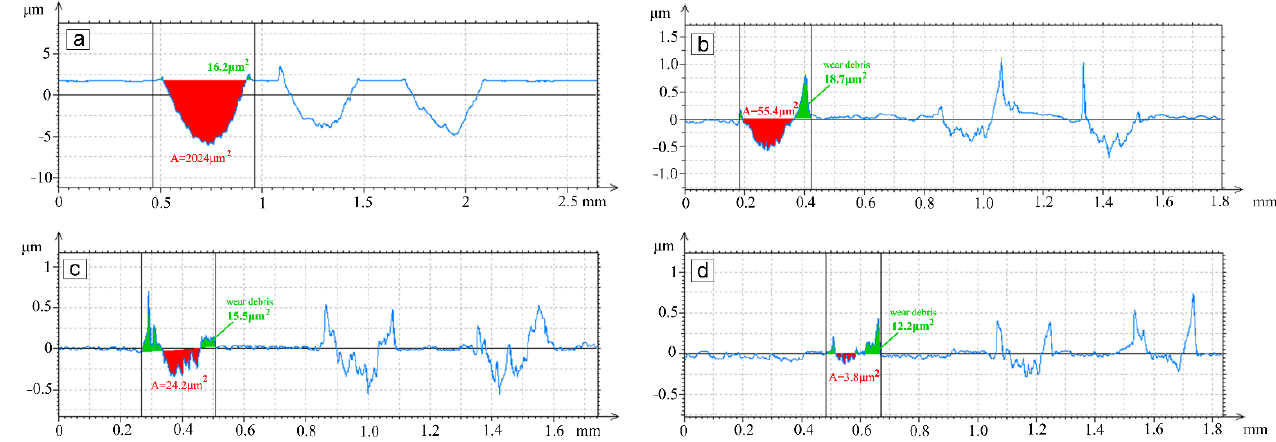
Figure 9. Depth of wear tracks from profile measurements: ( a ) NiCrBSi, ( b ) NiCrBSi + 30 wt.% WC-12Co, ( c ) NiCrBSi + 50 wt.% WC-12Co, ( d ) WC-12Co coating.